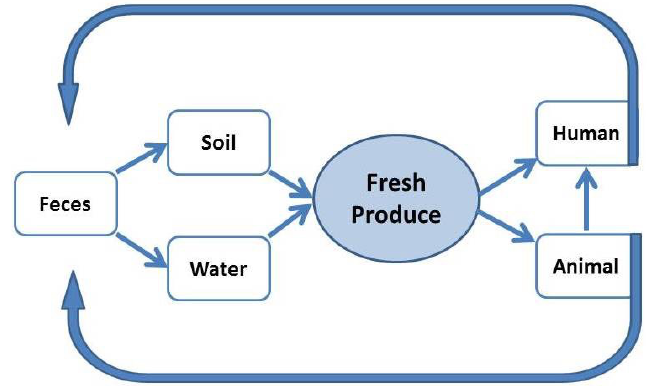
Figure 1. Potential pathways of L. monocytogenes transmission to humans via fresh produce.